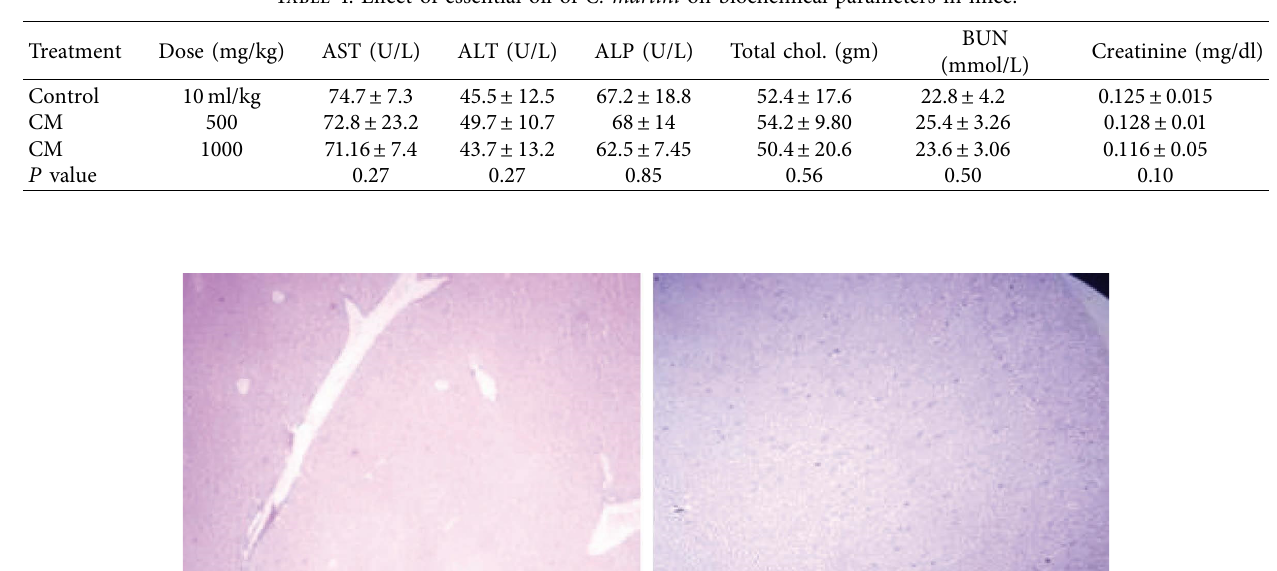
Table 4: Efect of essential oil of C. martini on biochemical parameters in mice.